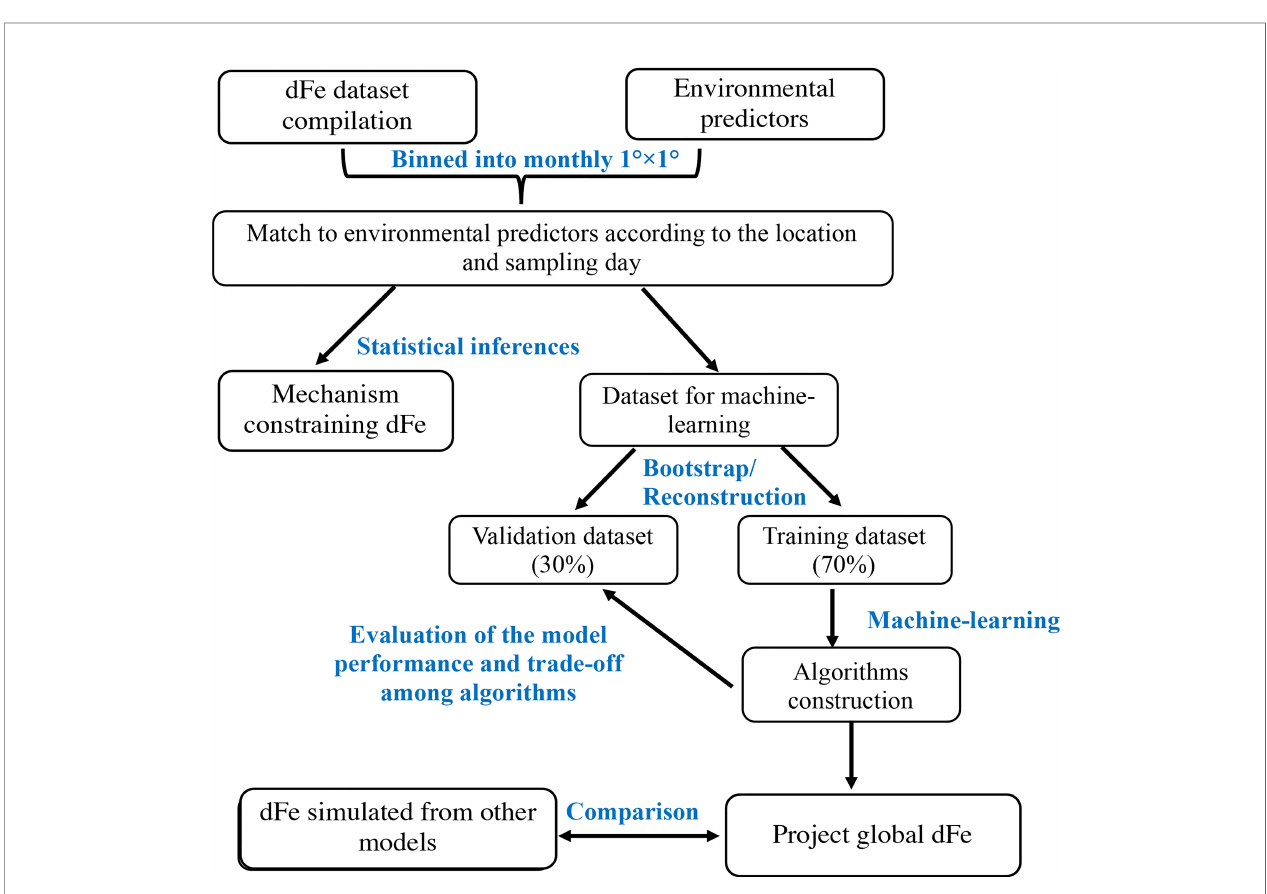
FIGURE 2 | Work fl ow for the data processing, model construction and statistical